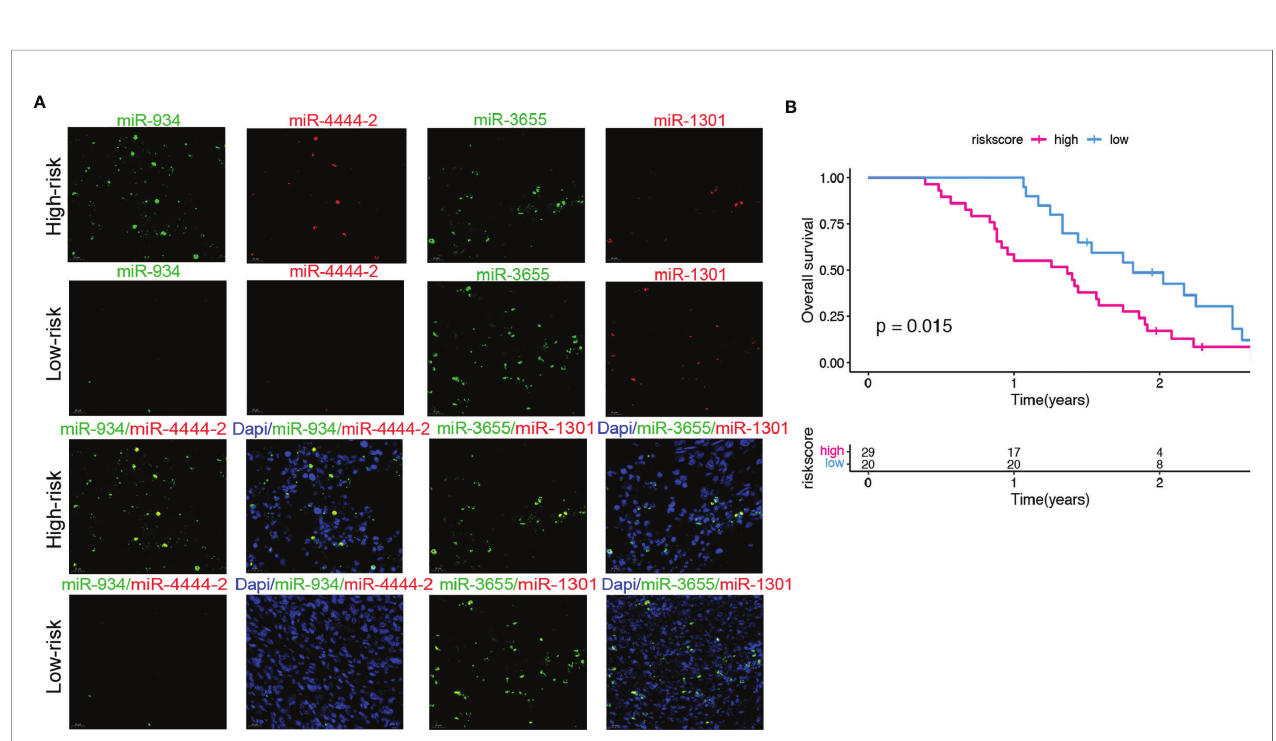
FIGURE 9 | Validation of the predictive ability of the risk model in a clinical external cohort. (A) Representative images of FISH (40× magni fi cation) of 4 miRNAs in PC patients tissue samples. (B) The correlation between overall survival based on clinical information and the scores of the risk group based on the 4 miRNAs expressions in PC patients tissue samples. Compared with the low-risk group, the high-risk group has a signi fi cantly lower overall survival rate. (log-rank test,